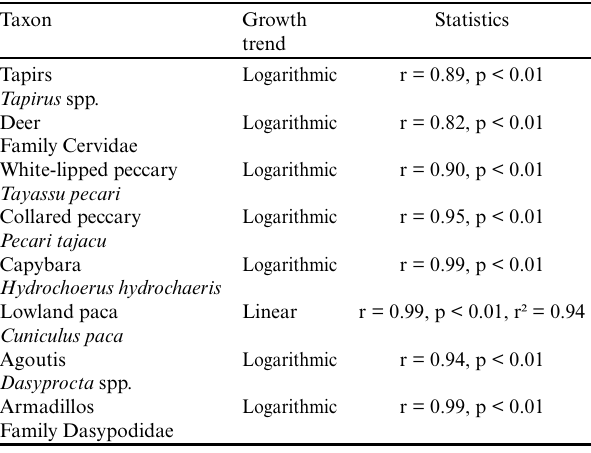
Fig. 4 . Accumulation curves along the YouTube™ results